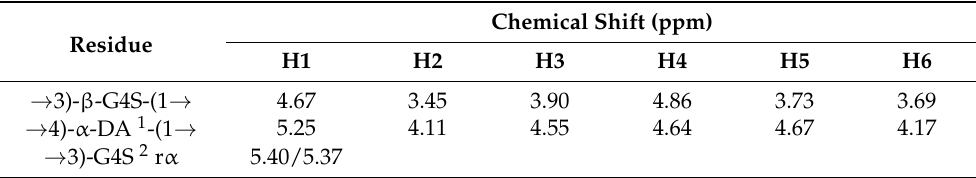
Figure 3. NMR spectra of the KSCOs: ( A ) 1 H NMR spectrum; ( B ) 13 C NMR spectra. Blue indicates- chemical shift. Table 1. 1 H-NMR chemical shifts of κ -selenocarrageenan